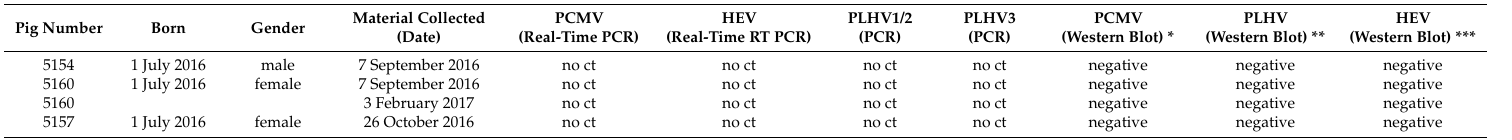
Table 2. Screening of animals 5154 (donor pig), 5160, and 5157 (sibling pigs) for potentially zoonotic porcine viruses. HEV: hepatitis E virus; PLHV: porcine lymphotropic